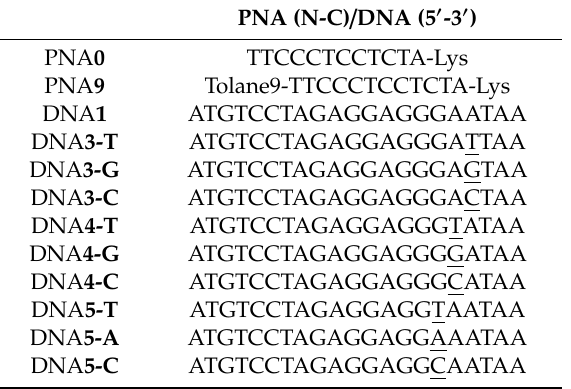
Table 5. UV-melting temperature analysis of PNA 0 and PNA 9 with DNA containing a single